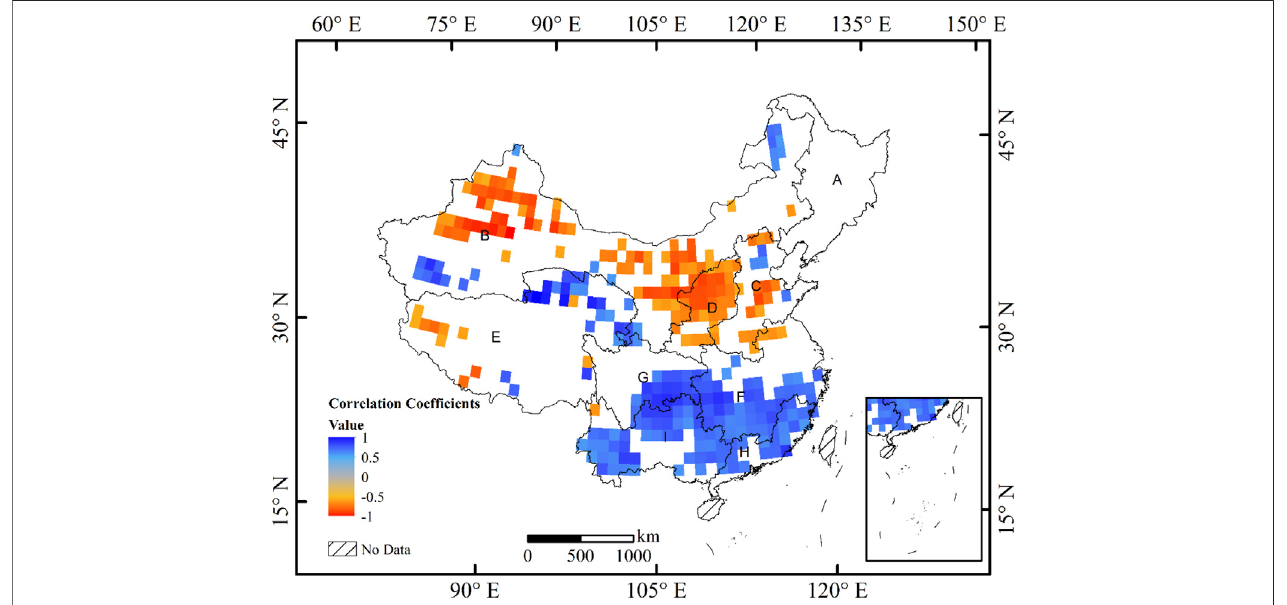
FIGURE 5 | Spatial Correlation between TWS and CNDVI with p -value under 0.05 [ (A) Northeast China Plain, (B) Northern arid and semi-arid region, (C) Huang- Huai-HaiPlain, (D) LoessPlateau, (E) QinghaiTibetPlateau, (F) Middle-lowerYangtzePlain, (G) SichuanBasinandsurroundingregions, (H) SouthernChina, (I) Yunnan- Guizhou